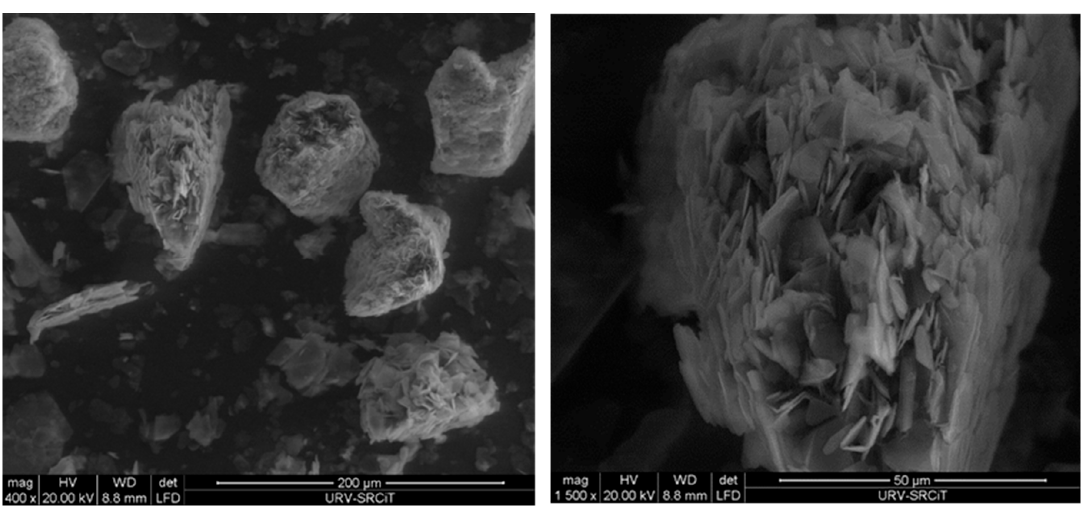
Figure 9. ESEM micrographs of the pure BN agglomerates at 400 ( left ) and 1500 ( right ) magnifications.